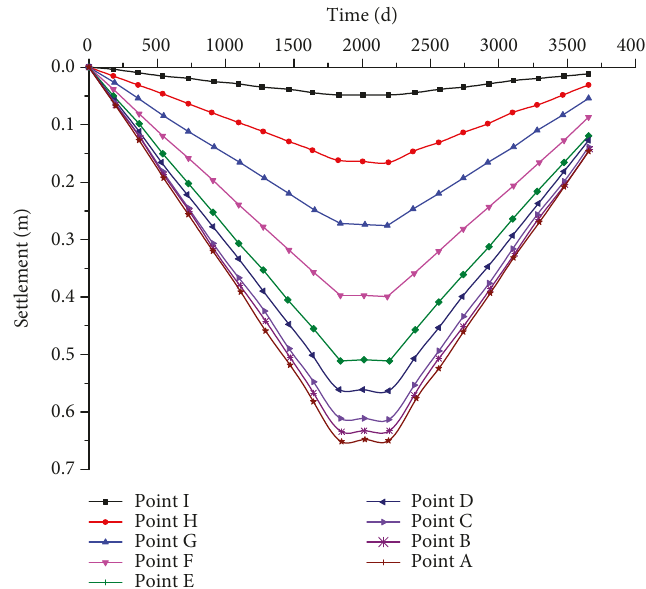
Figure 13: Ground settlement changing with time in case Π